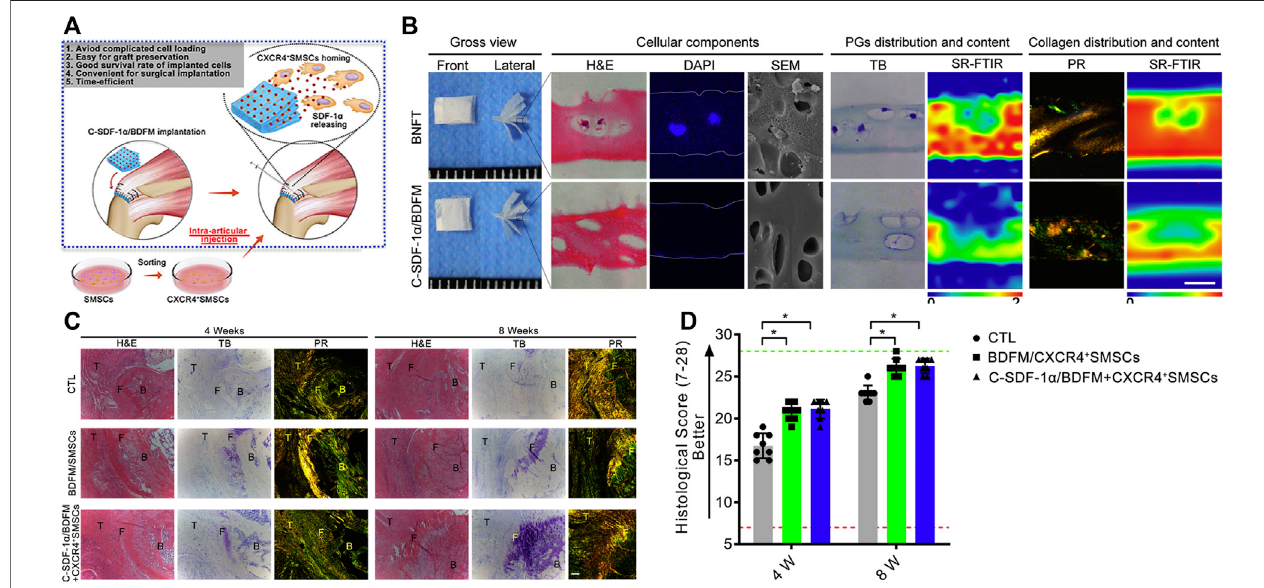
FIGURE 5 | Functional decellularized fi brocartilaginous matrix graft for rotator cuff enthesis regeneration: A novel technique to avoid in-vitro loading of cells. (A) Developing a cell-free graft with chemotaxis to recruit postoperative injected cells; (B) Macroscopic observation, histological analysis, and synchrotron radiation-Fourier transform infrared spectroscopy analysis of the book-type nature fi brocartilage tissues and C-SDF-1 α /BDFM, sections stained with hematoxylin and eosin (H&E), DAPI, toluidine blue (TB), and picrosirius red (PR); (C , D) Histological analyses of regenerated fi brocartilage during RC healing. Copyright 2020 Elsevier.